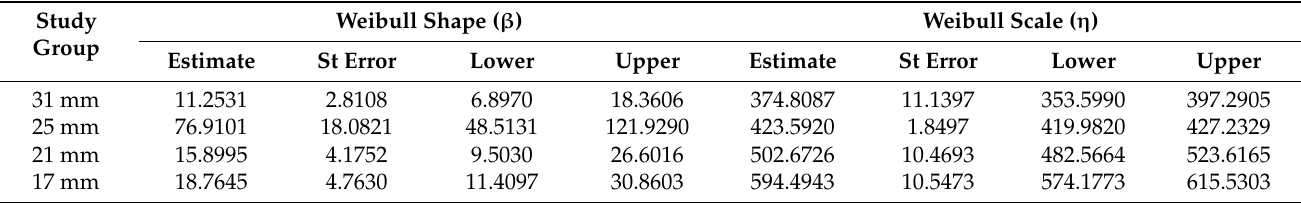
Table 2. Weibull statistics of the time to failure for each study